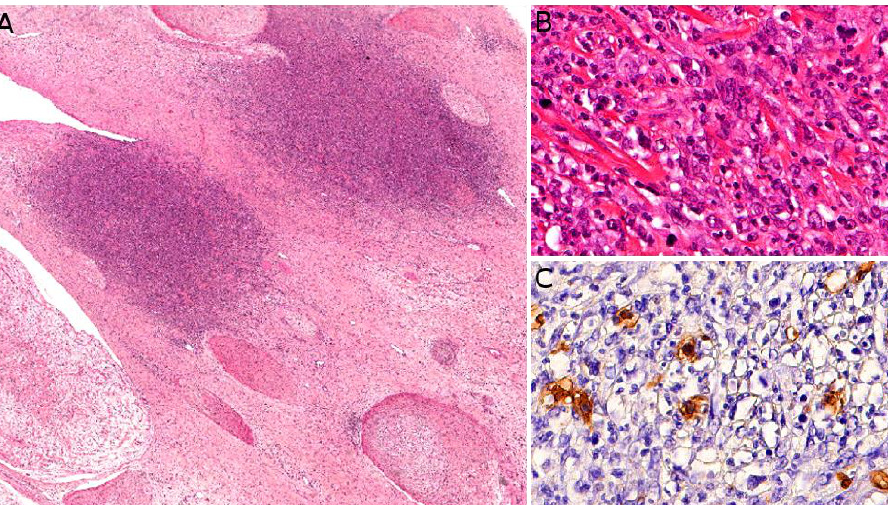
Figure 14. Malignant peripheral nerve sheath tumor (MPNST): ( A ) MPNST arising on a pre-existing plexiform neurofibroma in a child with NF1, note the two highly cellular areas among the otherwise poorly cellular plexiform neurofibroma ( × 25); ( B ) higher view of one of the MPNST areas showing nuclear atypia and numerous mitoses ( × 100); ( C ) partial loss of S100 expression with only sparse positive cells ( ×